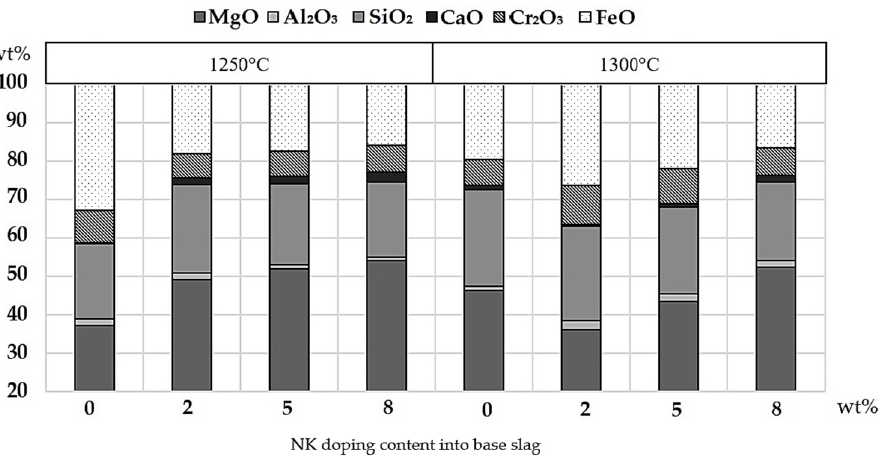
Figure 8. Infiltrated slag composition determined by SEM-EDS v/s NK doping into the base slag at 1250 and 1300 °C.